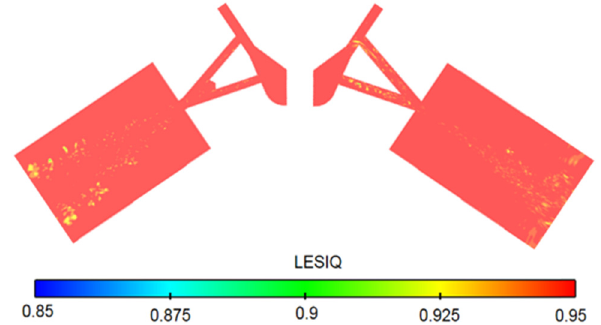
Figure 3: Evaluation of mesh